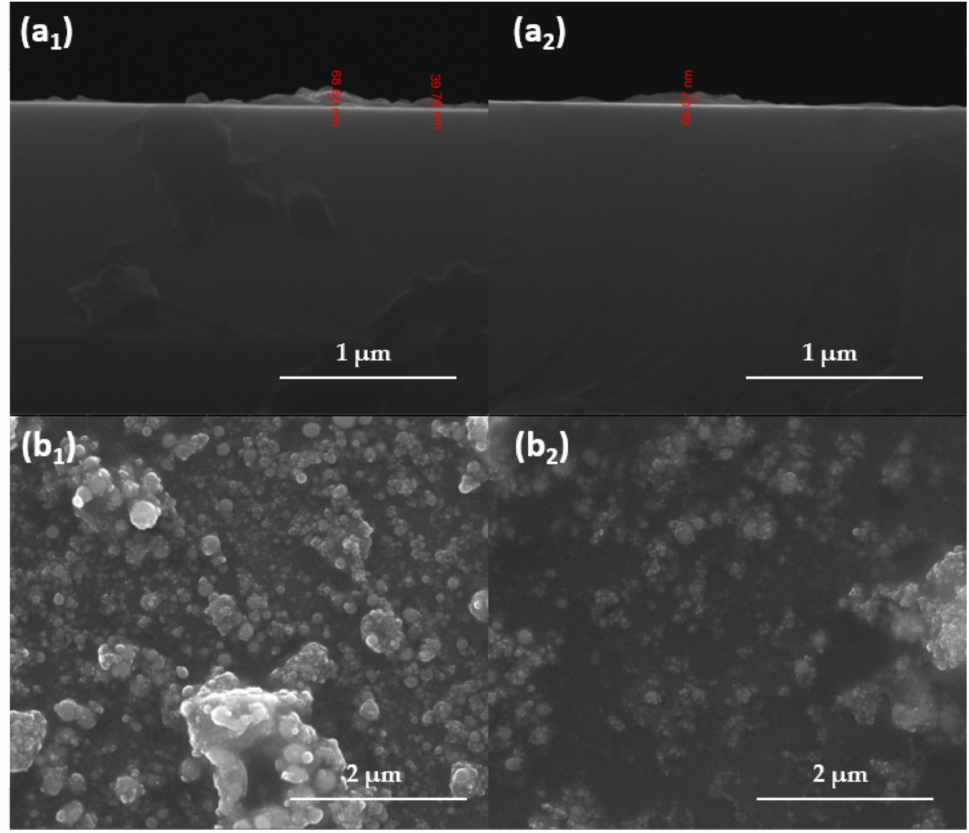
Figure 8. SEM images of Fe 3 O 4 @PEG (1) and Fe 3 O 4 @PEG/PM (2): ( a ) cross-section; ( b ) coatings